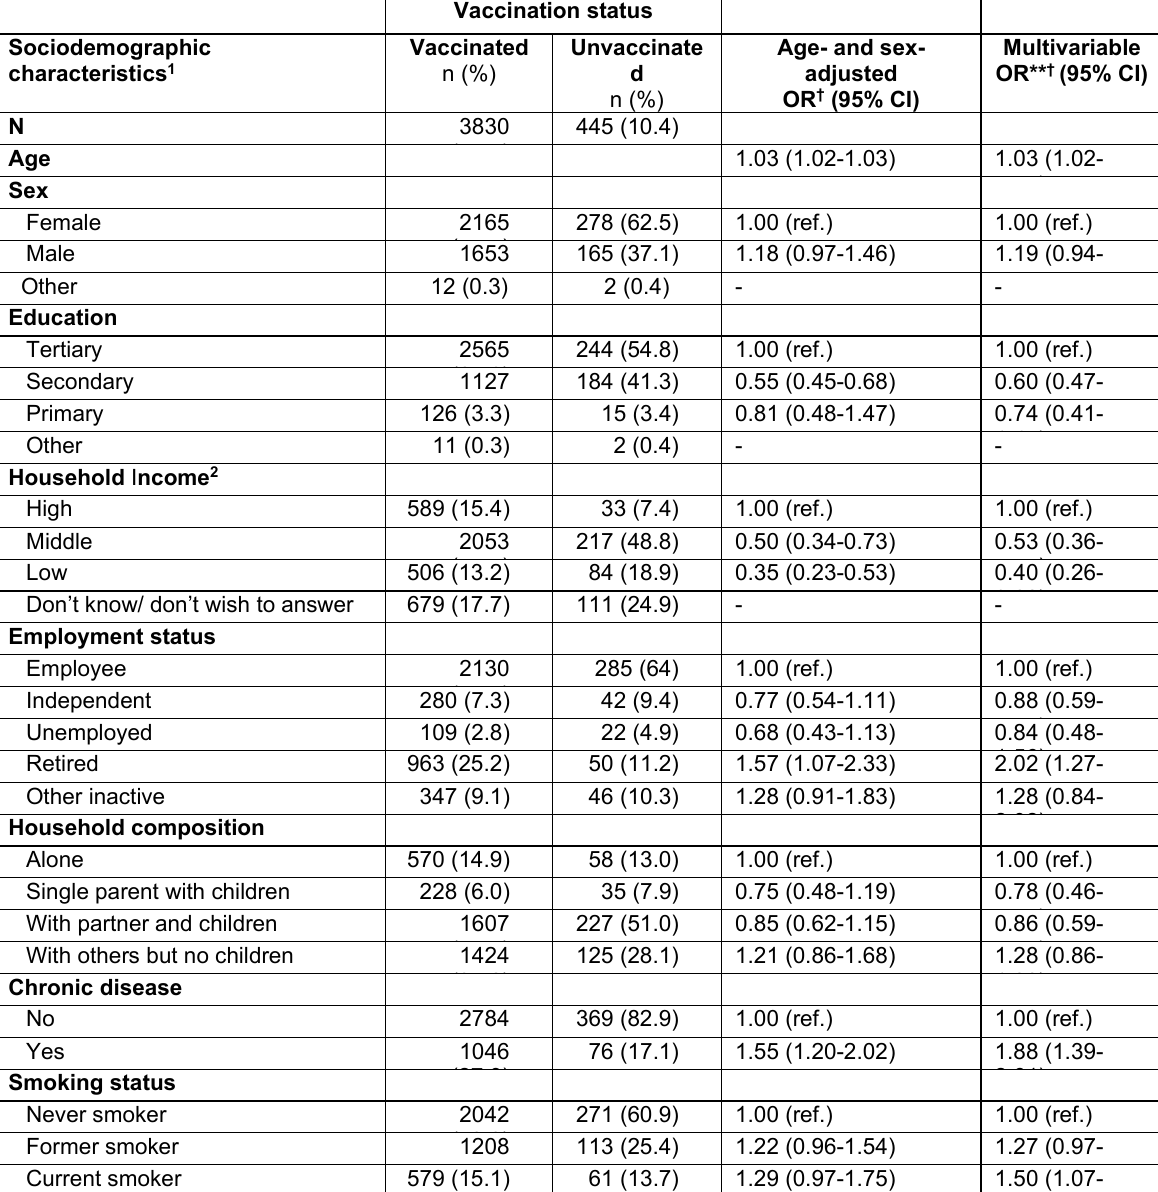
Supplementary table 6. Association of socio-demographic and health-related factors with vaccination status of adults in overall